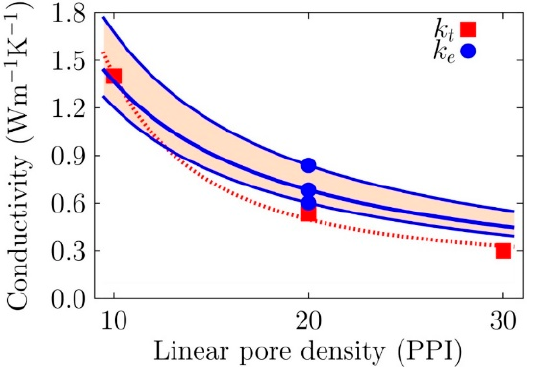
Figure 11. Total conductivity (k t ) obtained from the simulations for different linear pore densities (red squares) and a trendline for these values (red dotted line). The effective conductivity (k e ) [43] for the 20 PPI absorber (black circles) with the expected scaling for this quantity (black dotted line) based on the assumption of radiation heat transfer dominance [57].